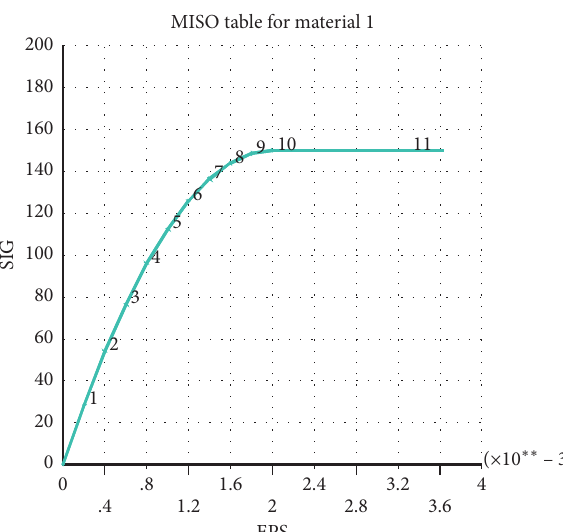
Figure 19: Constitutive model of steel concrete.